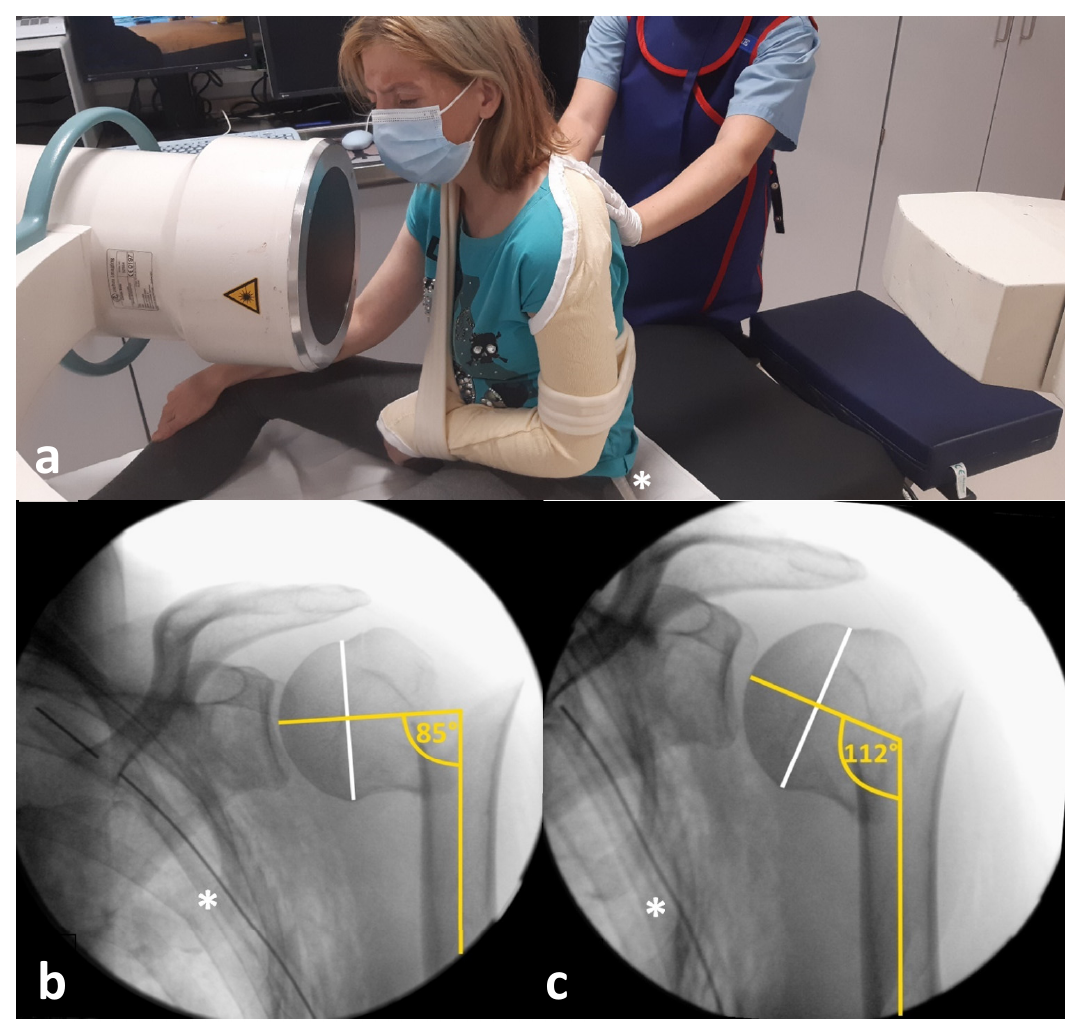
Figure 2. Patient no. 5 is mobilized into an upright sitting posture by a nurse assistant while the affected left shoulder is immobilized in a sling The ipsilateral chest tube is marked with an asterisk (*) ( a ). Fluoroscopic images of patient no. 5 in lying ( b ) and in an upright sitting posture ( c ), showing an immediate self-reducing effect with respect to HSA through patient mobilization. A white line is drawn from the superior to the inferior border of the articular surface. A perpendicular yellow line is drawn to this line and through the center of the humeral head. The angle between this line and another yellow line bisecting the humeral shaft is measured as HSA. An ipsilateral chest tube due to serial rib fractures with pneumothorax is marked with an asterisk (*).